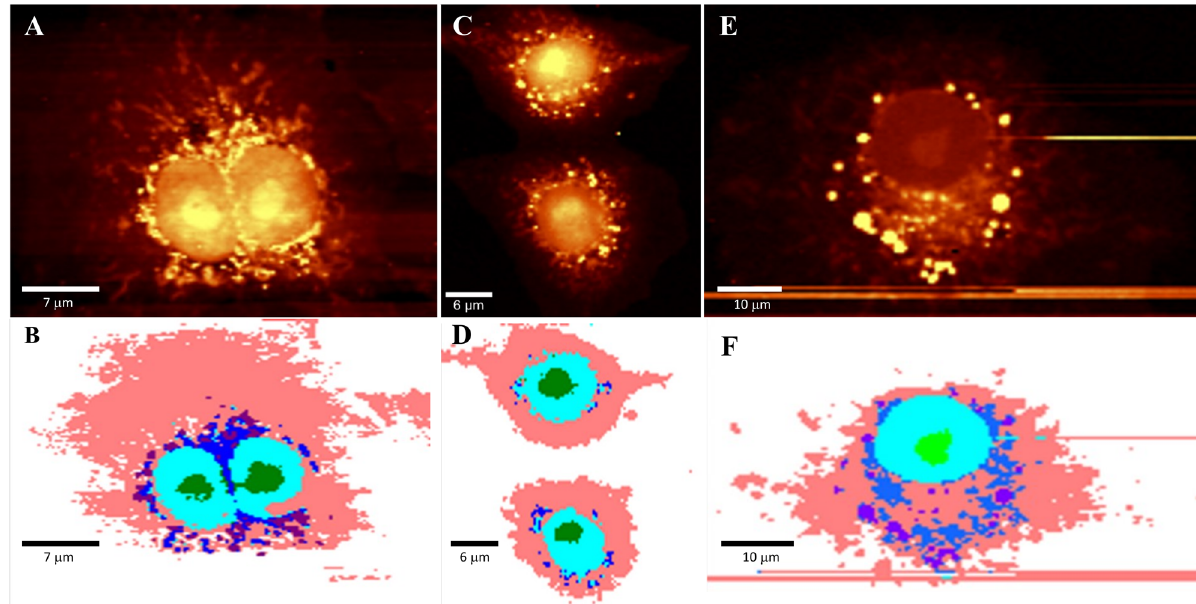
Fig. 1 Raman confocal images of SARS-CoV-2 and MeV-infected (24 h pi) and noninfected Vero E6 cells. A Raman images of noninfected cells Light yellow color corresponds to the highest intensities of lipids and proteins and dark shadow for the lowest intensities. B KMCA results for the noninfected cells of part A. The nucleolus is marked in dark green, the nucleus in turquoise, mitochondria and Golgi are in blue, cytoplasm in pink and lipid droplet in purple. The same color code has been used for all analyses. C SARS-CoV-2-infected Raman C-H images and D relevant KMCA illustrations for the C part. E MeV-infected Raman C-H images and F relevant KMCA illustrations for E part. Scale bars are variable between 6 – 10 µ m as